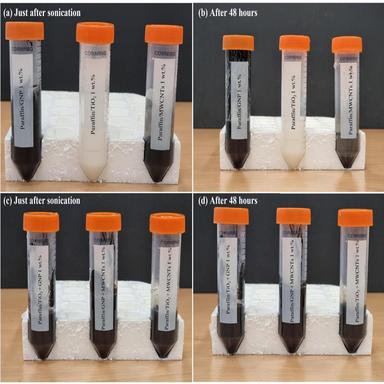
Status of samples with a time duration. (a) Single type particles-based nanocomposites just after sonication, (b) single type particles-based nanocomposites after 48 h (c) hybrid type particles-based nanocomposites just after sonication, (d) hybrid particles-based nanocomposites after 48 h.